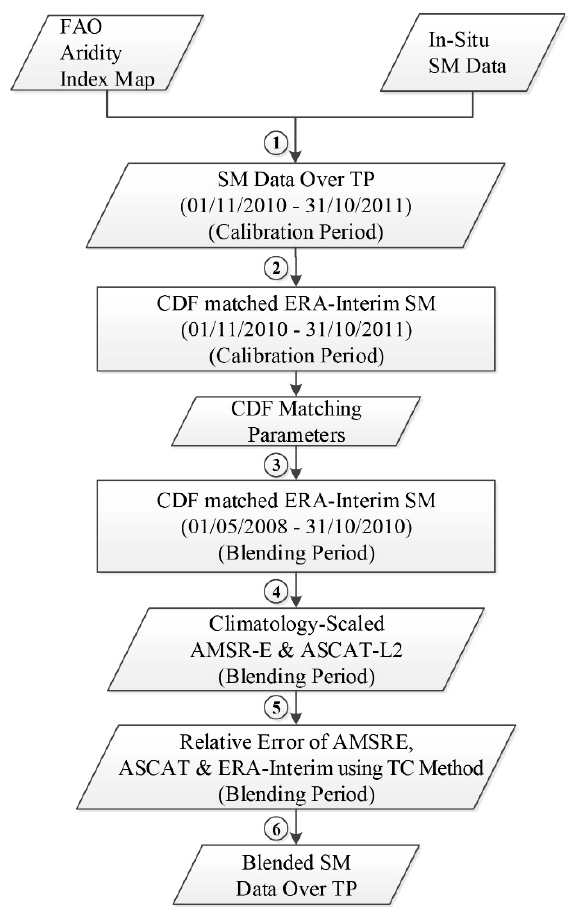
Figure 3. The flowchart of scaling and blending strategy deployed in this study.